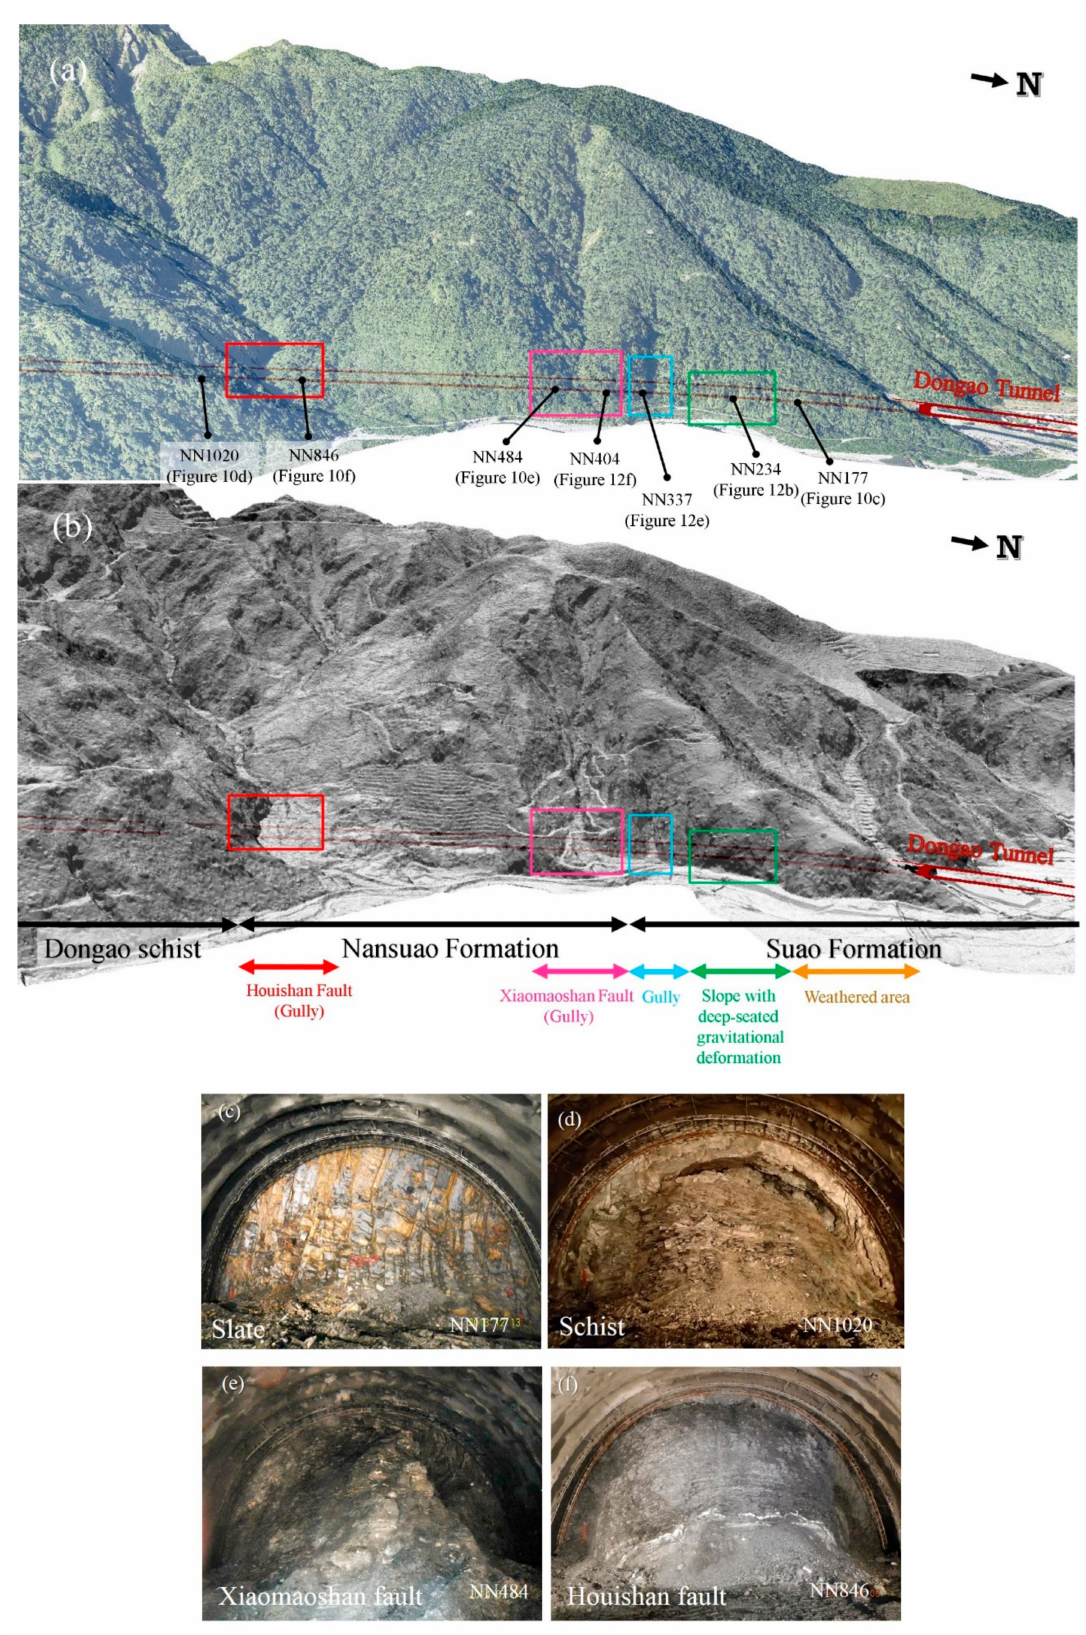
Figure 10. 3D terrain model ( a ), digital elevation model ( b ), and images of the excavation face captured during tunneling in the slate of Suao Formation ( c ), the schist of Dongao Schist Formation ( d ), the Xiaomaoshan Fault ( e ), and the disturbed zone of the Houishan Fault ( f